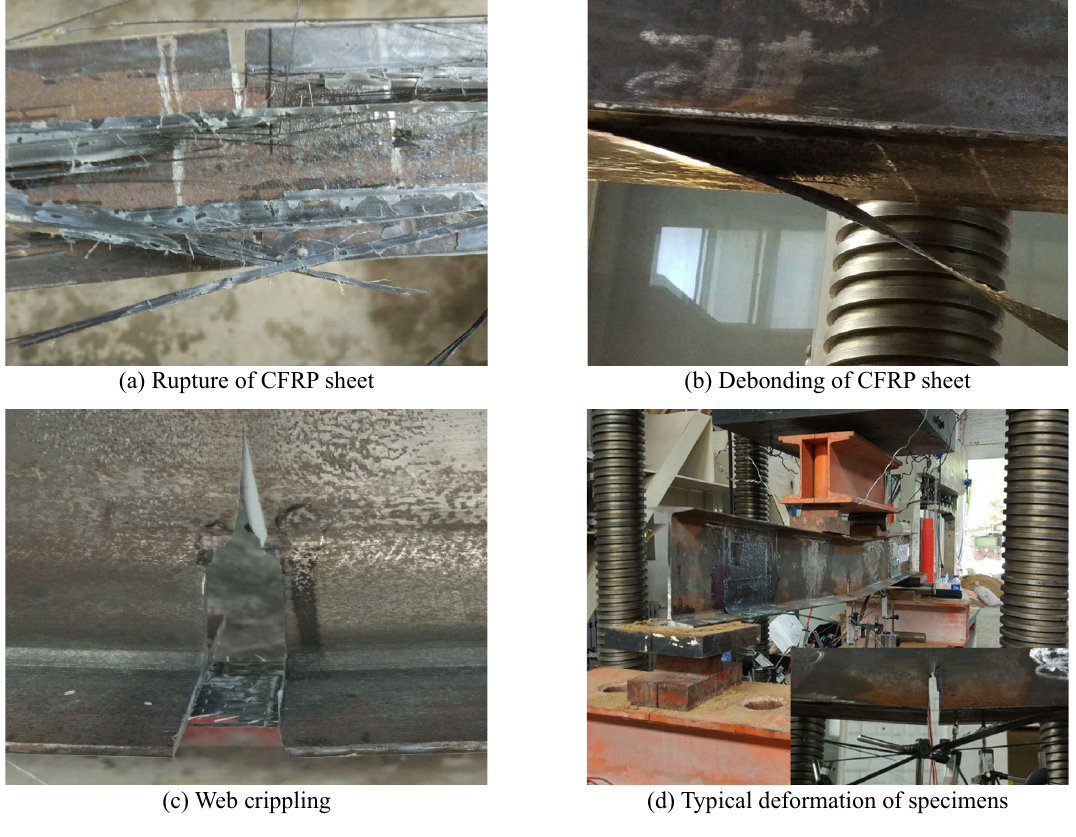
Figure 4. Failure modes of test specimens.